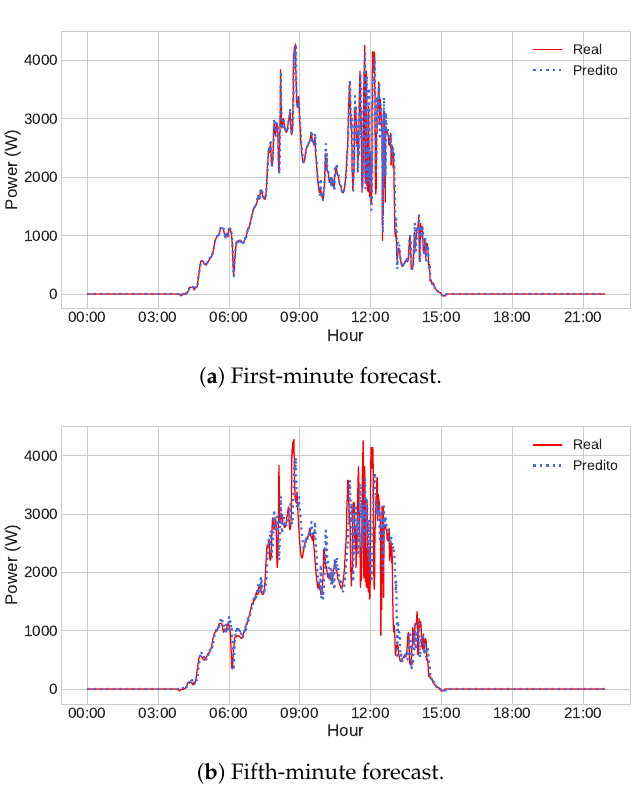
Figure 10. Power forecast by the optimized LSTM model (blue dots) and the actual power values (red line) on the cloudy day of 01/04/2022, considering ( a ) the first-minute forecast and ( b ) the fifth-minute